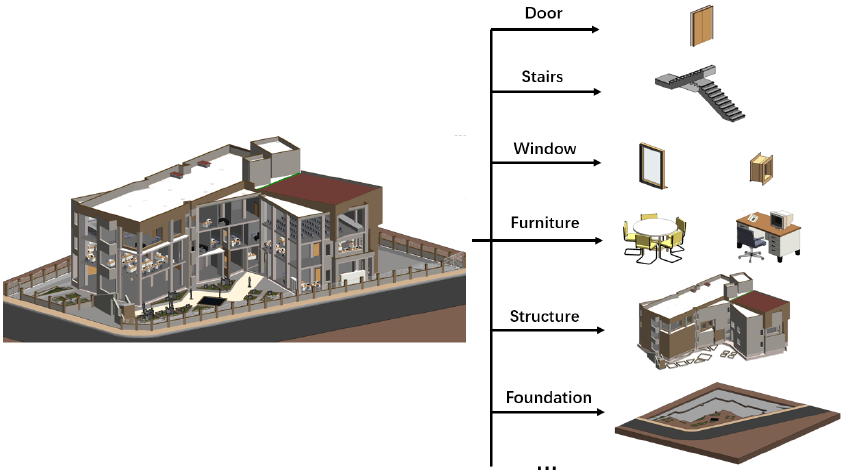
Figure 1. Subassemblies of a 3D BIM model.